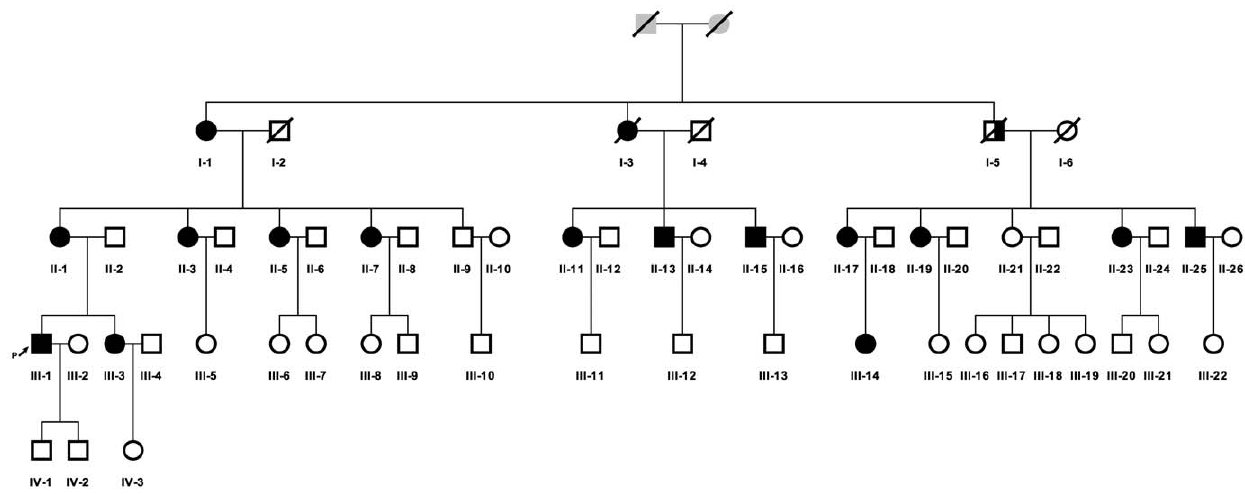
Figure 1. Pedigree of the family. ( % male; # female; 8 index patient; & definitely